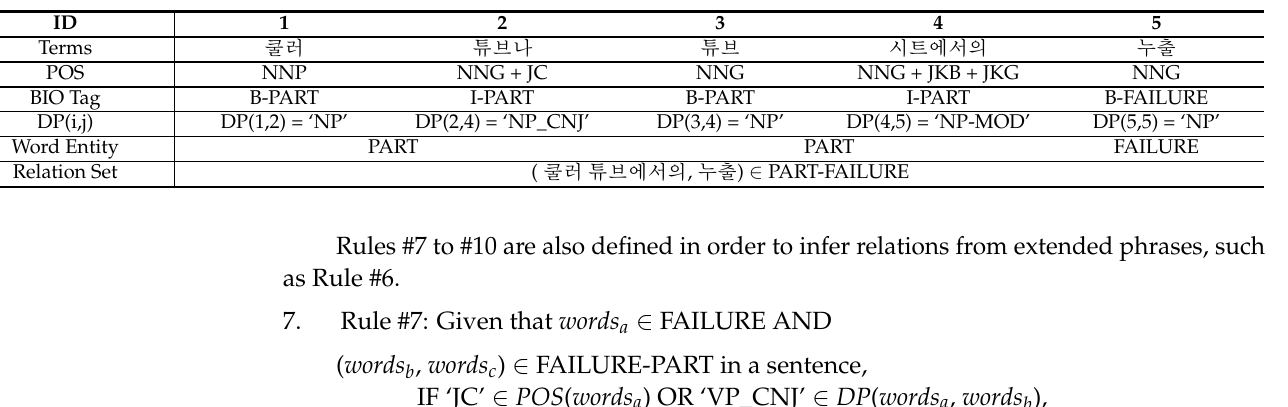
Table 8. An example of the results by applying Rule